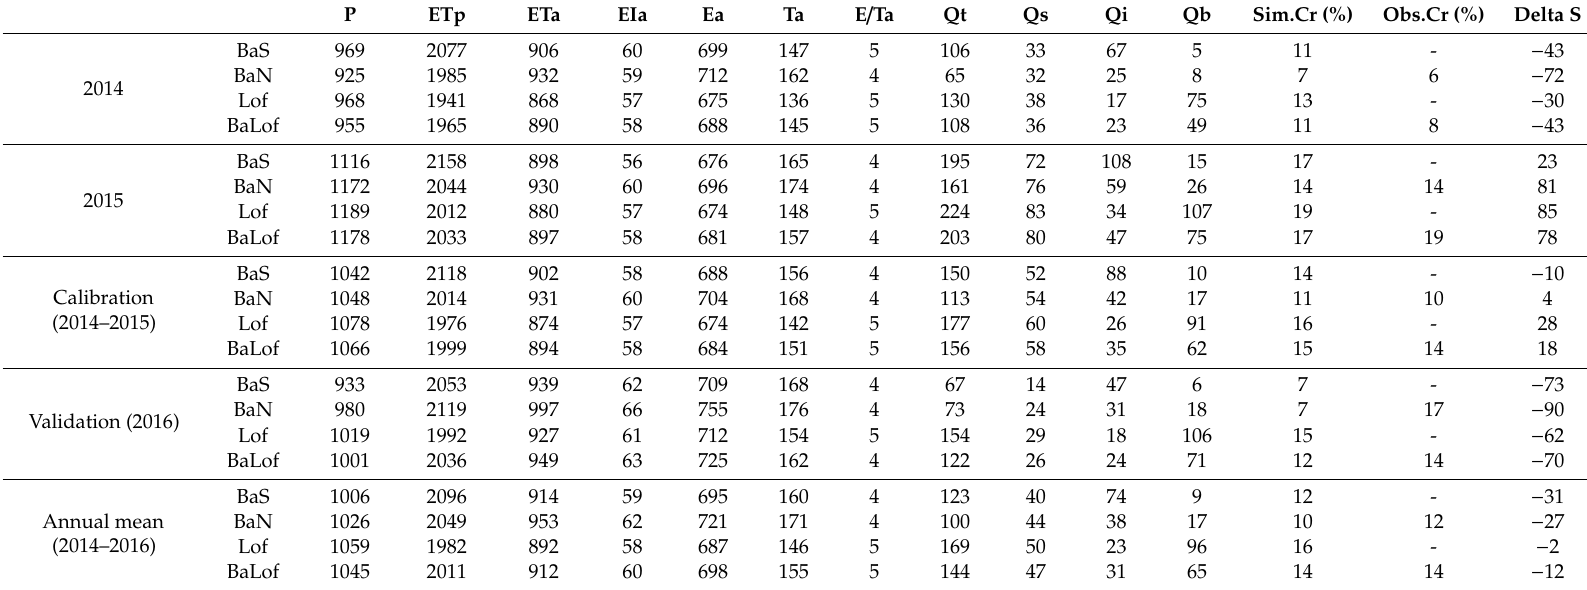
Table 4. Average annual water balance in mm / a at the Bankandi-Lo ffi ng catchment for the years